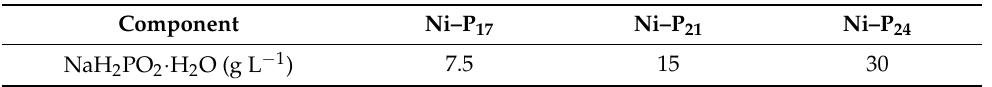
Table 1. Composition of various nanostructured Ni–P electrocatalysts realized by tuning the hy- pophosphite